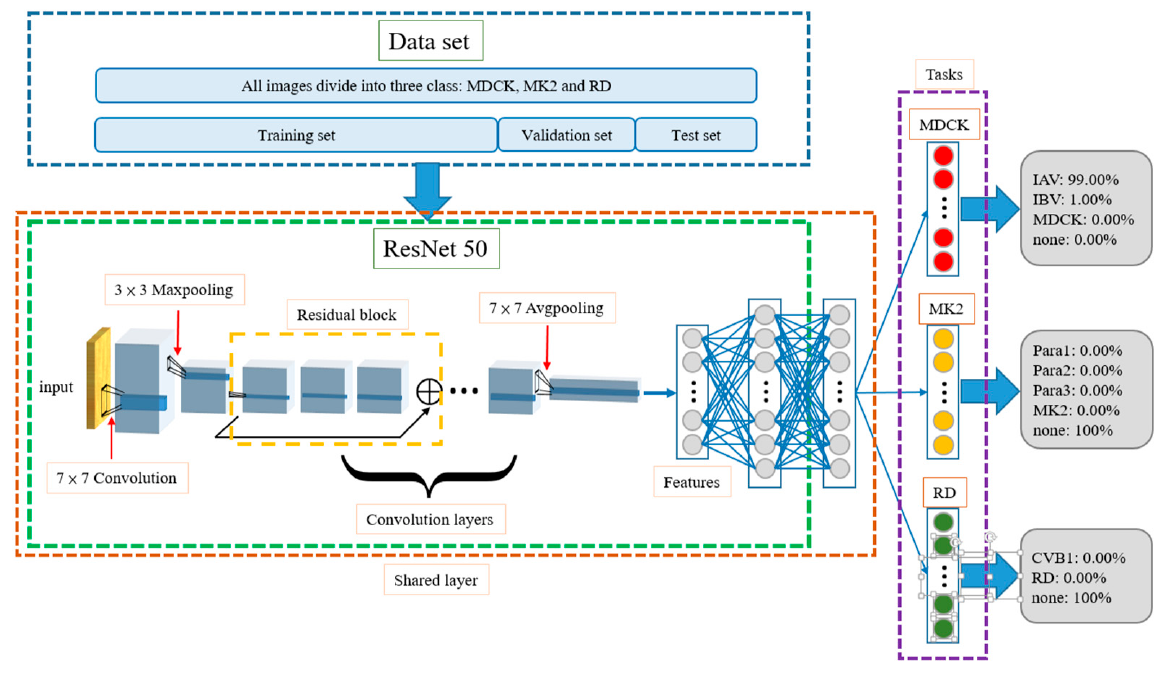
Figure 4. Architecture of multi-task learning model. The front-end convolution layers and fully con- nected layers share information with each other through shared layer. For example, the model eval- uates the input image as MDCK task and the IAV has the highest possibility.